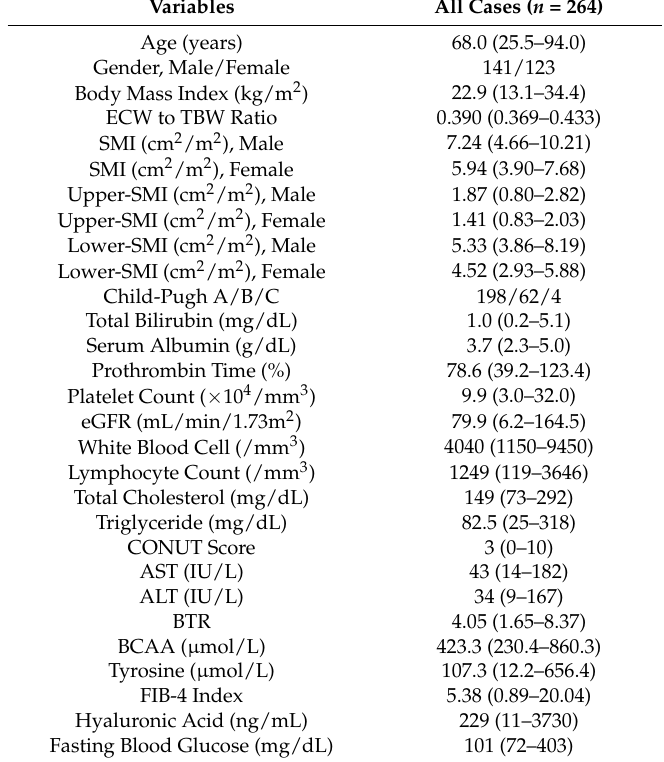
Table 2. Baseline data ( n = 264).